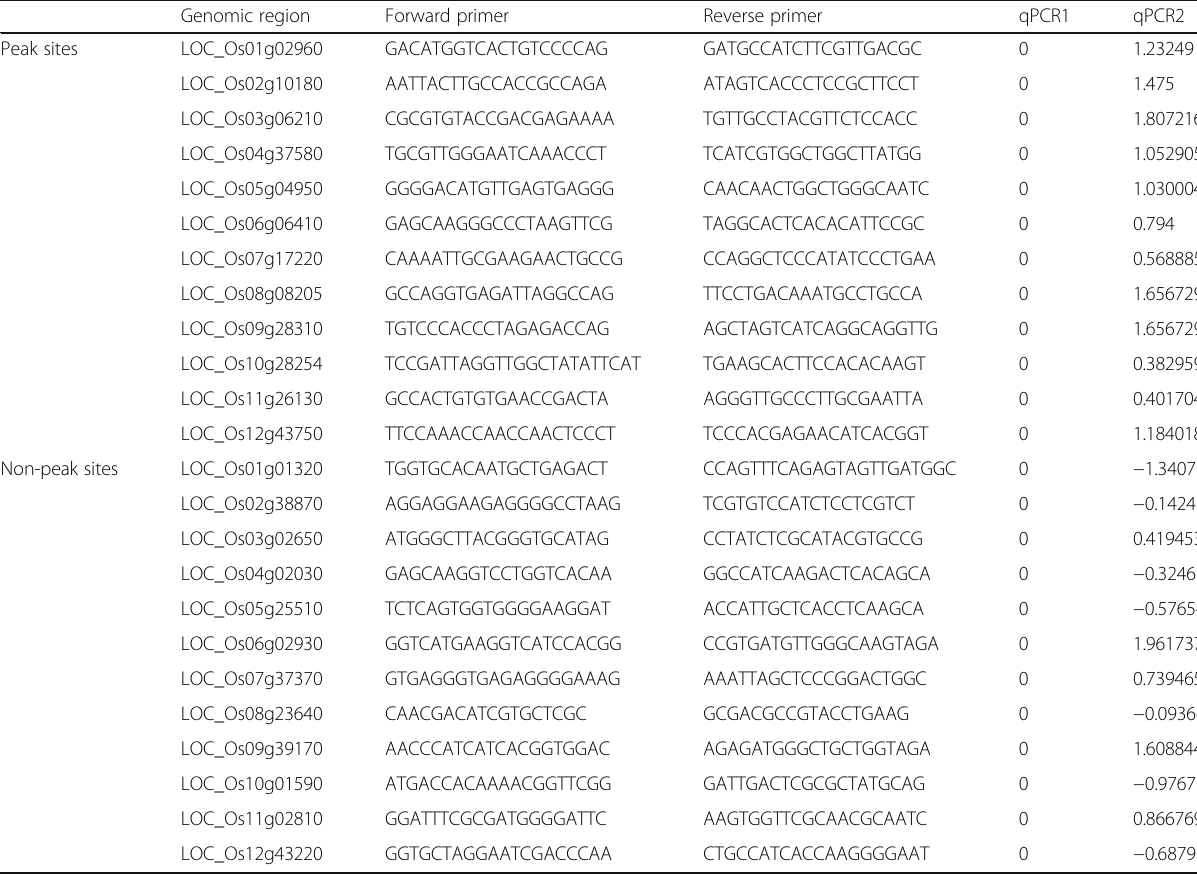
Table 2 Confirmation of Kbu peak sites and non-peak sites by quantitative PCR Genomic region Forward primer Reverse primer Peak